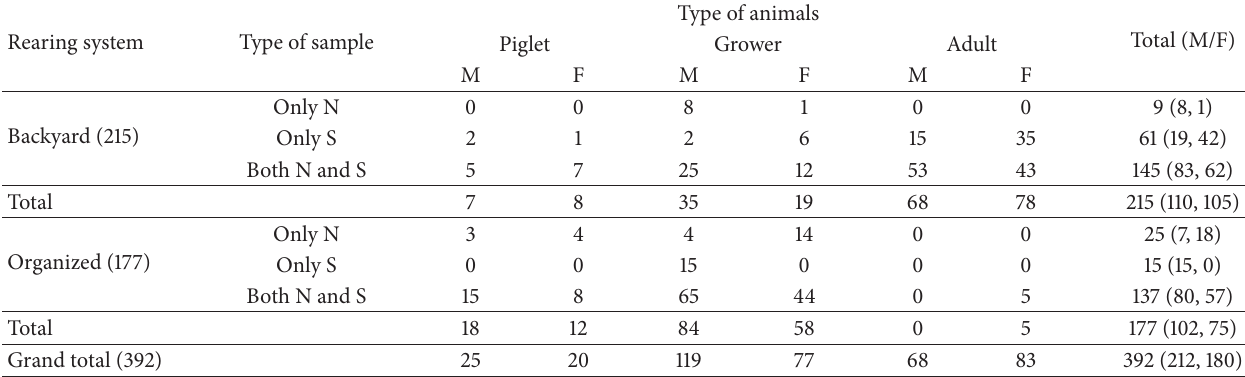
Table 1: Details of samples collected from pigs under different rearing systems.